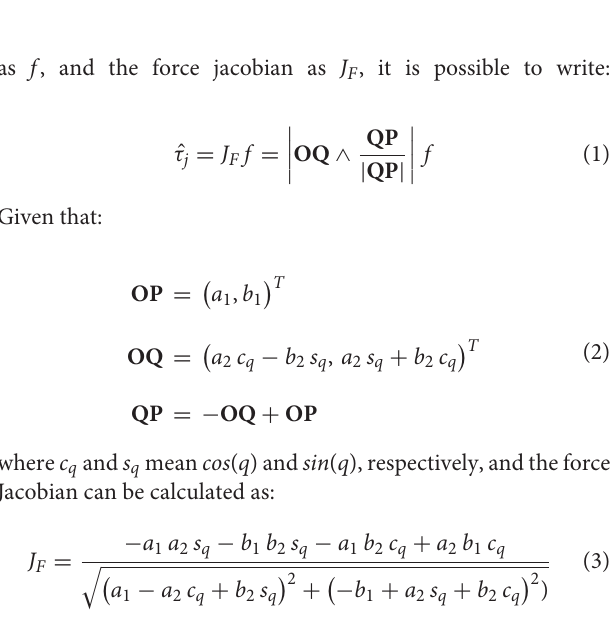
TABLE 1 | Geometrical parameters used for the calculation of the force Jacobian. Parameter a 1 a 2 b 1 b 2 Value [m] 0.22 0.08 0.05